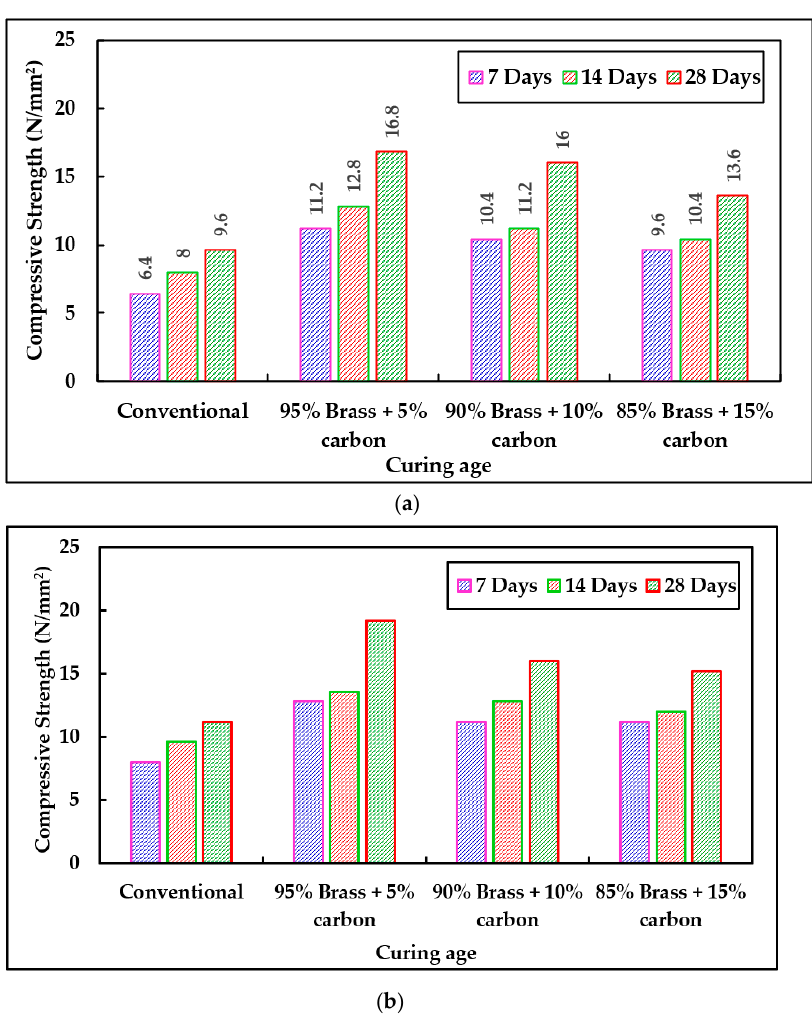
Figure 8. Graphical illustration of mortar cube compressive strength with hybrid fibres added. ( a ) Air curing; ( b ) Water curing.